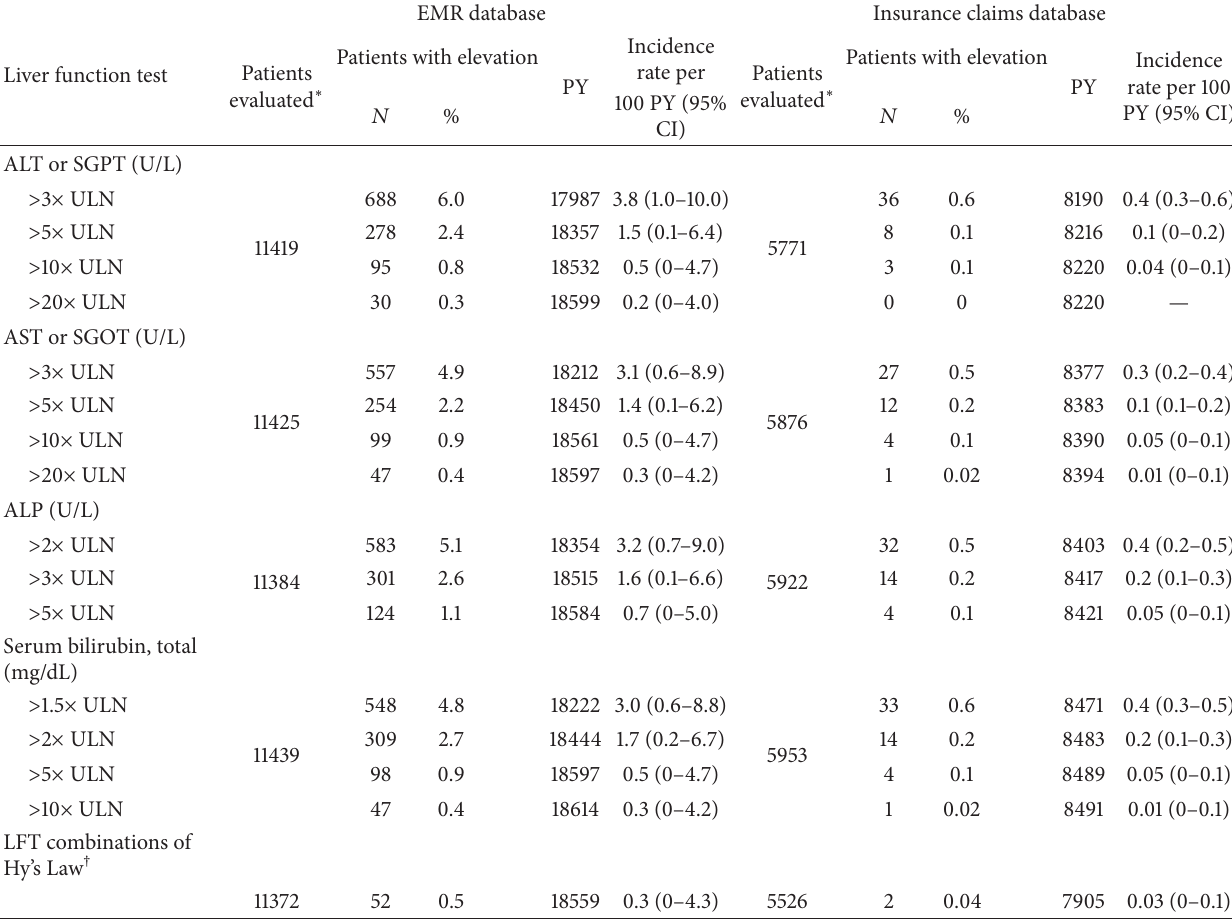
Table 3: Incidence of first occurrence of each degree of elevation for multiple liver function tests, cancer